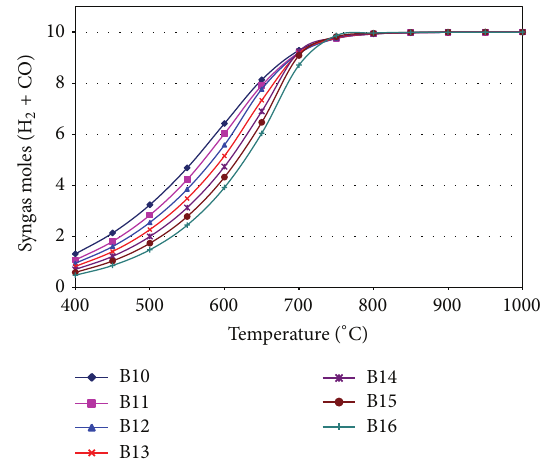
Figure 1: Syngas moles in CR of propane.